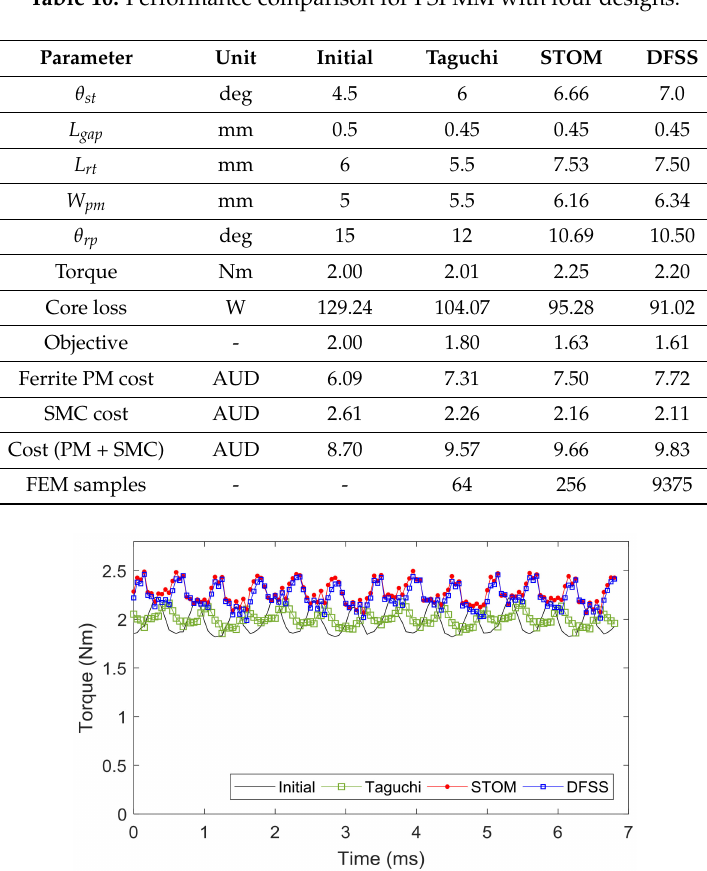
Table 10. Performance comparison for FSPMM with four designs.